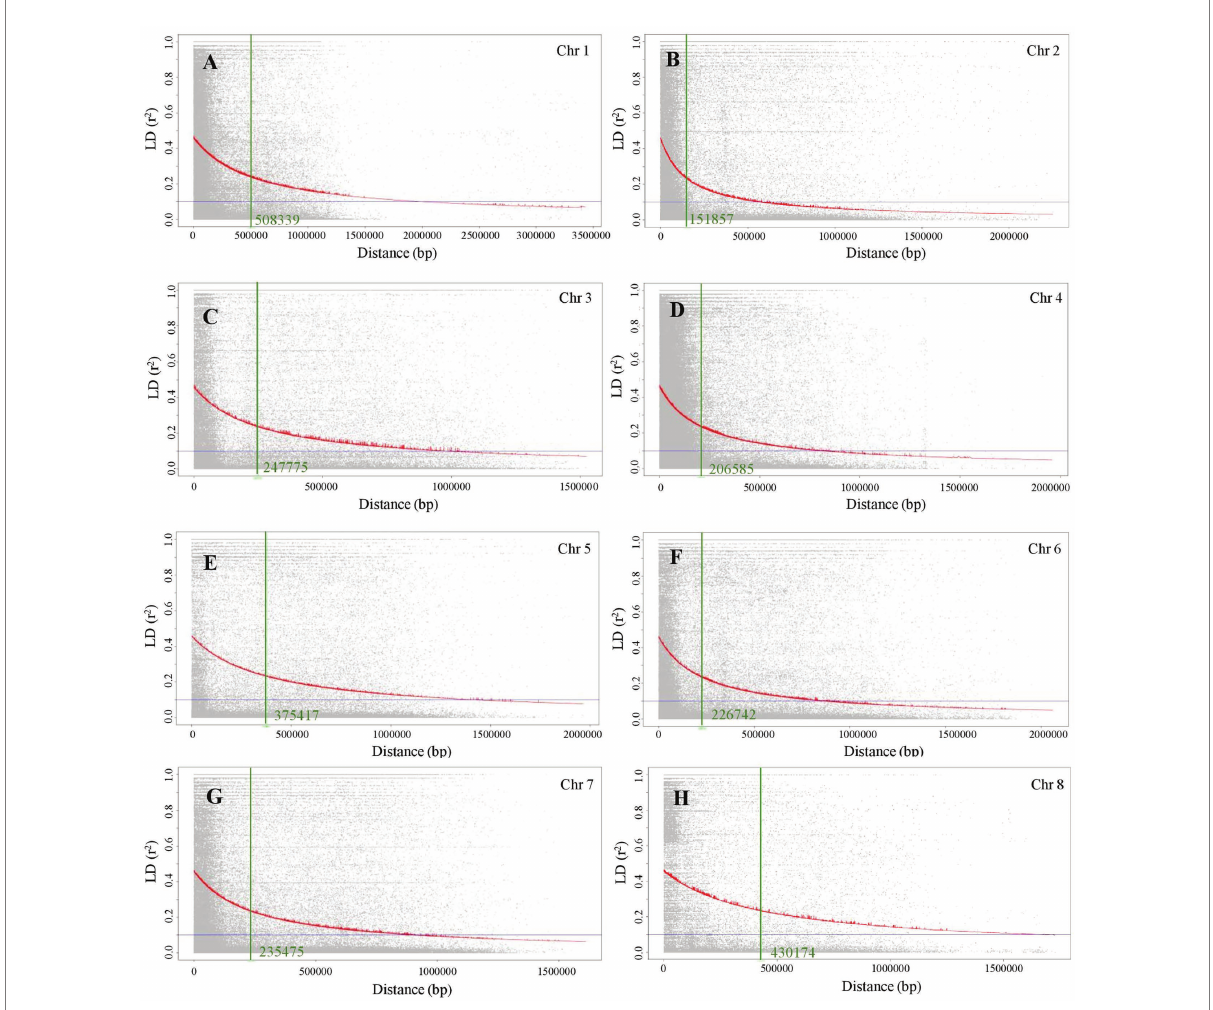
FIGURE 1 Linkage disequilibrium (LD) decay plots of eight chromosomes of chickpea. (A) Chromosome 1, (B) Chromosome 2, (C) Chromosome 3, (D) Chromosome 4, (E) Chromosome 5, (F) Chromosome 6, (G) Chromosome 7, and (H) Chromosome